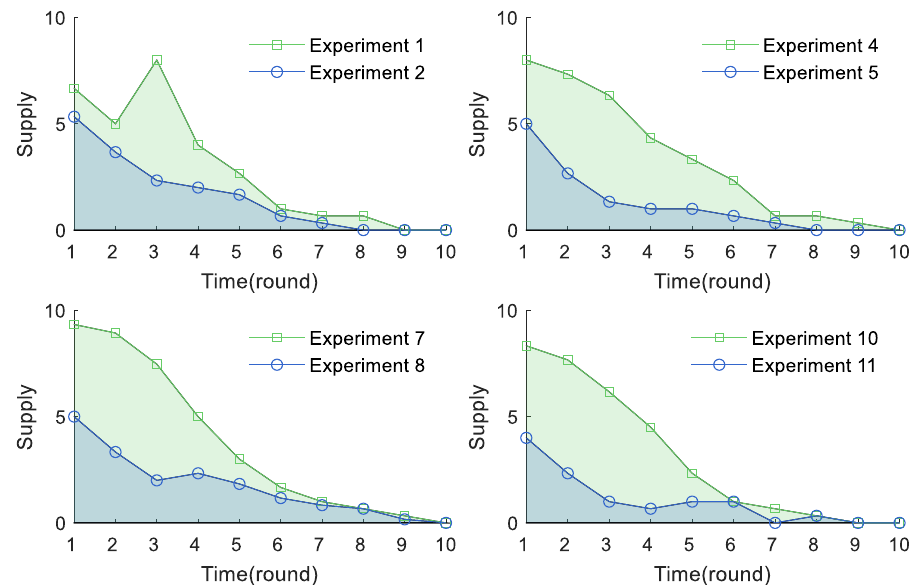
Figure 5. Effects of information feedback on supply. Table 6. Mann – Whitney U test of the effects of information feedback on supply.